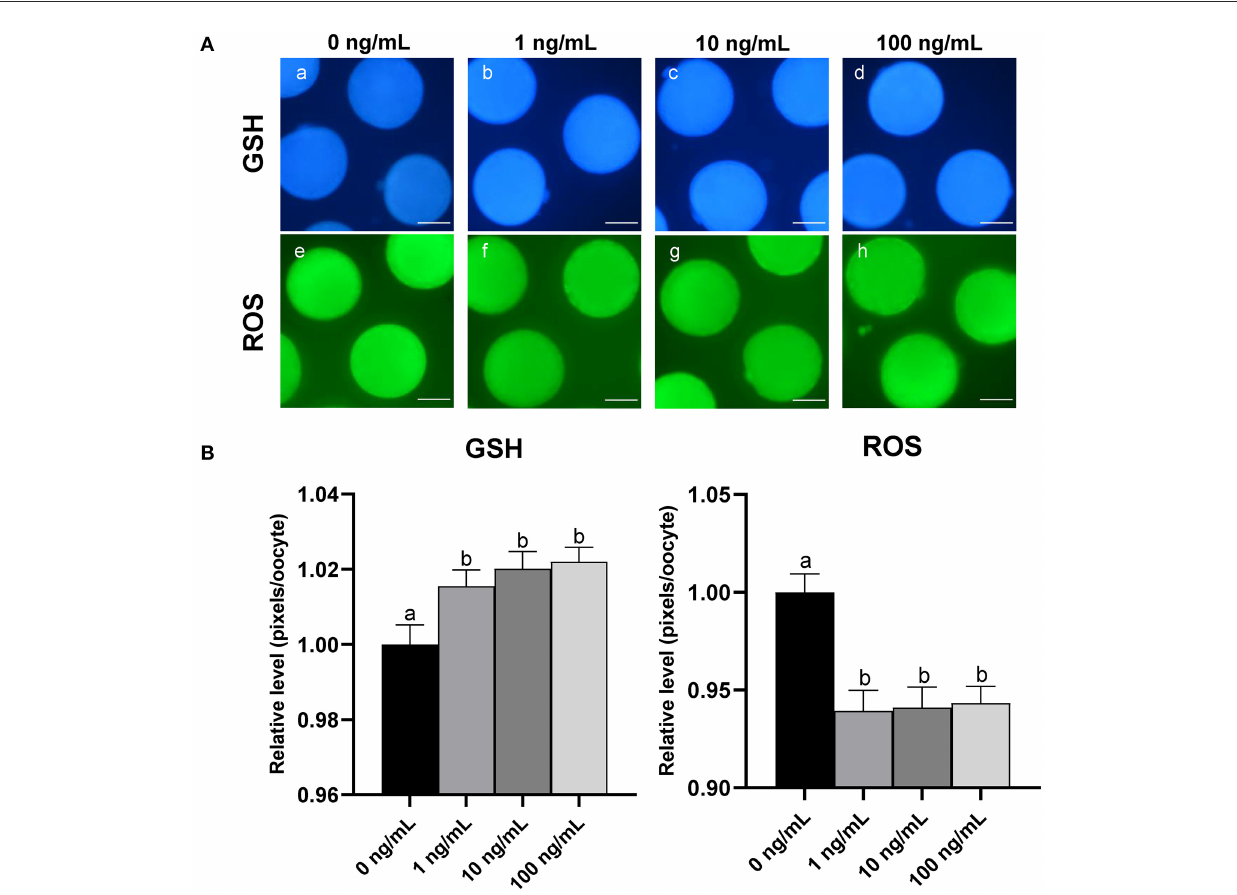
FIGURE3 Effect of CCL2 supplementation during IVM on cytoplasmic maturation. (A) Oocytes were stained with Cell Tracker Blue (a–d) and H 2 DCFDA (e–h) to detect intracellular levels of GSH and ROS, respectively. MII oocytes were derived from the control IVM system and the IVM system supplemented with various concentrations of CCL2. (B) Relative levels of intracellular GSH and ROS in in vitro mature porcine oocytes treated with CCL2 during IVM. Bars with different letters (a, b) are significantly different ( p < 0.05). The experiment was replicated three times. Scale bar = 50 µ